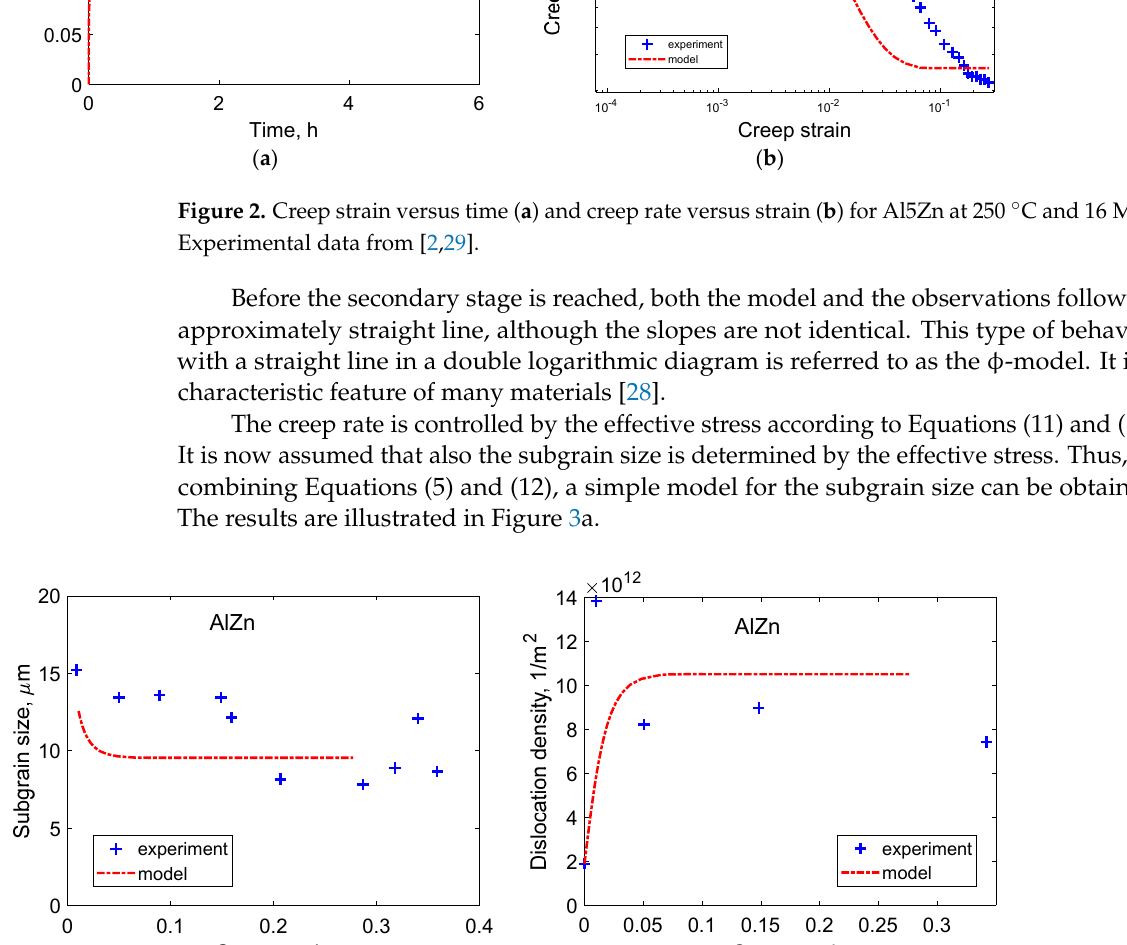
Figure 4. Dislocation separation in the subgrain boundaries versus strain for Al5Zn at 250 °C and 16 MPa. Experimental data from [2,29]. The general behavior of the observations can be described by the model in Figures 3 and 4, but the details are not fully accurate. 2.3. Cell Formation at Constant Strain Rate During tensile and compression testing at ambient temperature, dislocation cells are created in virtually all alloys. Koneva et al. [32] has made a brief review of cell formation.